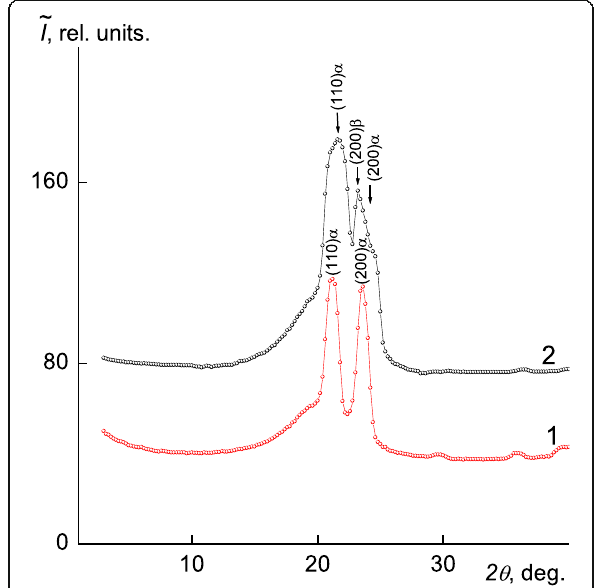
Fig. 5 SAXS intensity profiles for PE-80, PE-100, and PE-80/PE-100 welded specimens, received immediately after the welding process and in 1 year after the welding